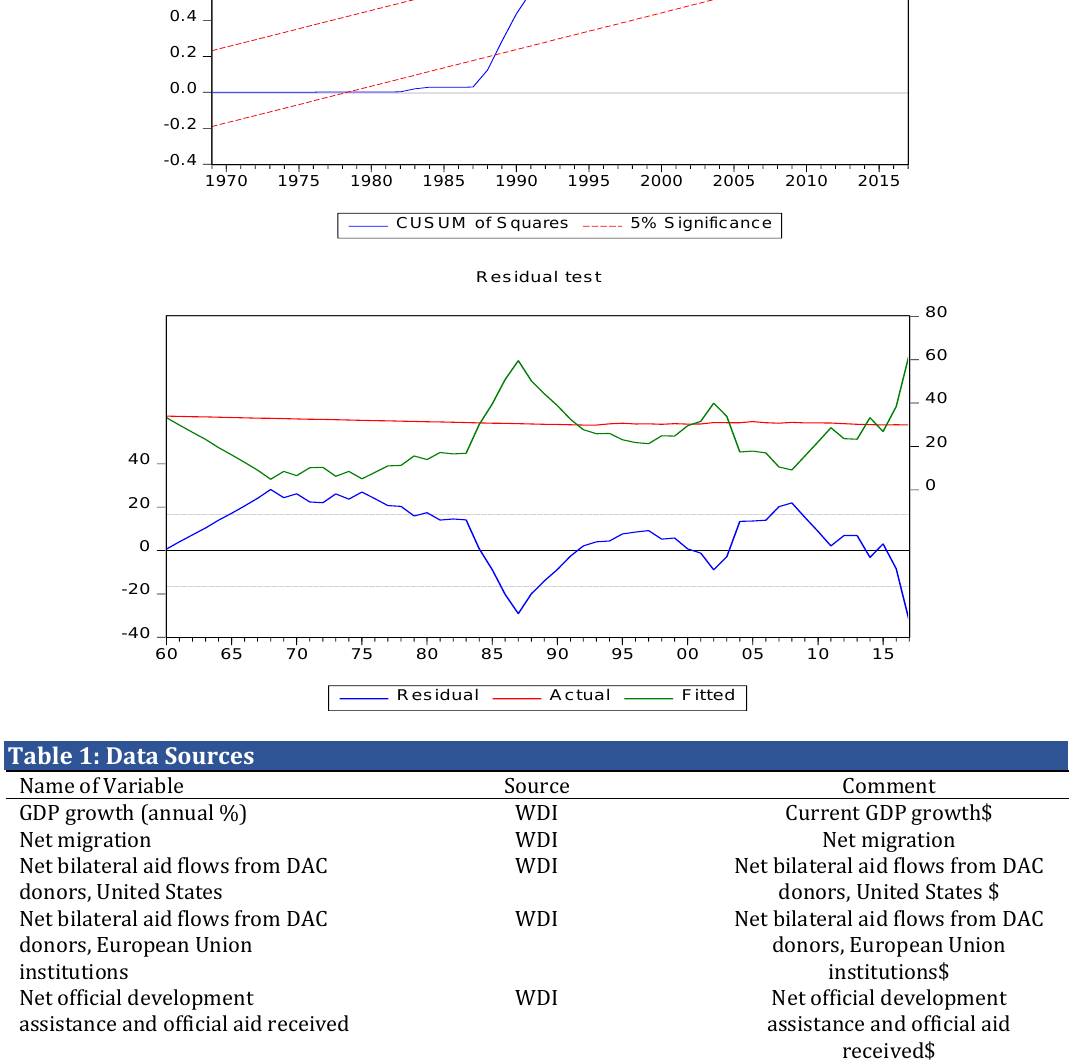
Table 1: Data Sources Name of